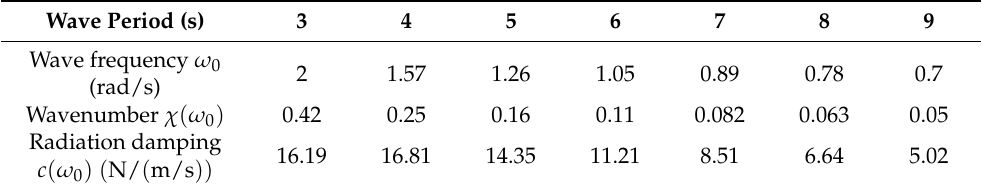
Table A1. Hydrodynamic parameters for different wave